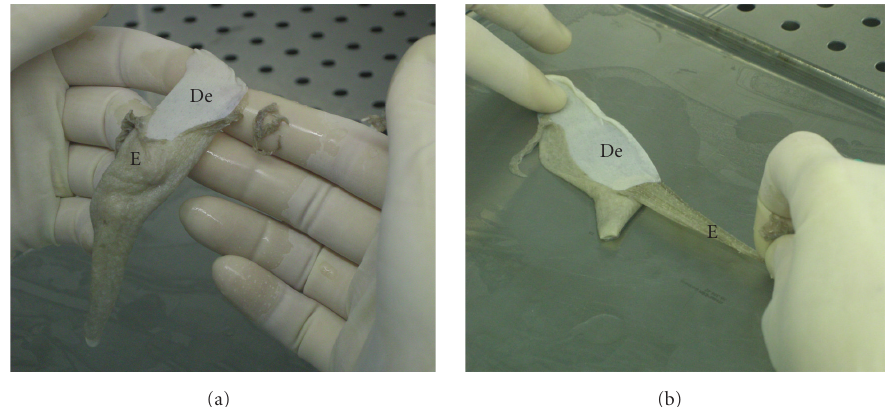
Figure 1: The manual removal involved massaging the graft by hand (a) followed by manual stripping of the epidermal layer, which detached very easily (b); E: epidermis, De: dermis.